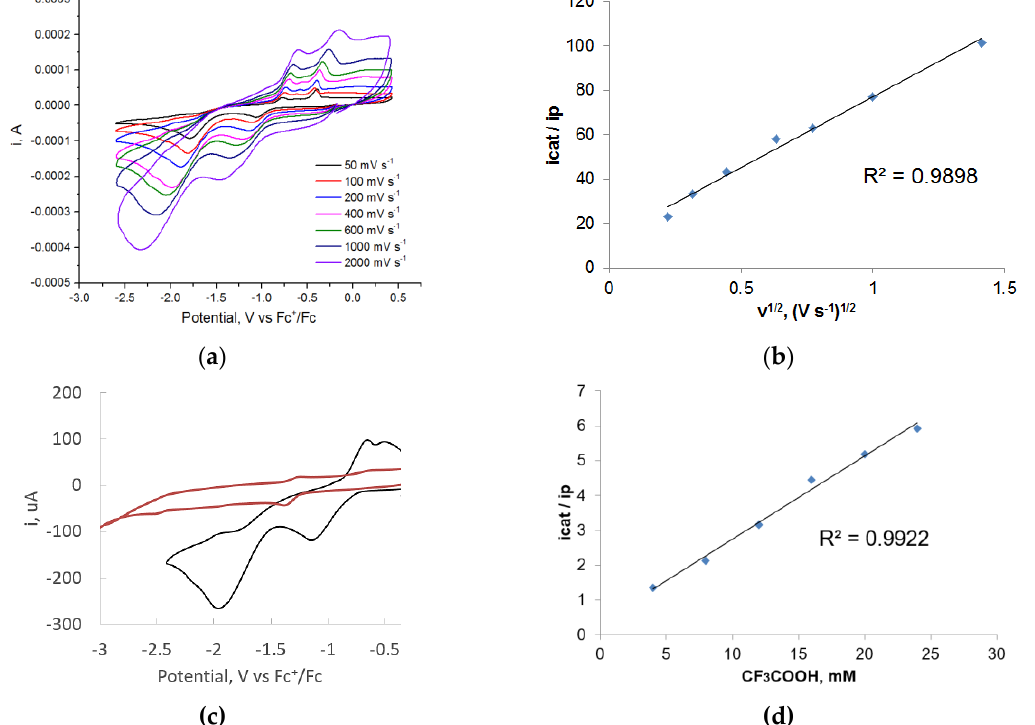
Figure 4. ( a ) CVs of 1 mM [1] + in 0.1 M Bu 4 NPF 6 DMF solution with 24 eq TFA at di ff erent scan rates ( b ) Plot of i cat / i p vs the square root of the scan rate ( c ) CV of [1] + 1 mM in DMF (0.1 M Bu 4 NPF 6 ) with 15 mM TFA added (black) and a subsequent CV (red) using the same electrode after performing electrolysis at a potential of − 1.7 V for 5 min, then rinsing with DMF and transfer to fresh DMF / 0.1 M Bu 4 NPF 6 solution without adding [1] + with 15 mM TFA ( d ) Dependence of the catalytic current, i cat / i p , on the concentration of TFA in a 1 mM [1] + and 0.1 M Bu 4 NPF 6 DMF solution.